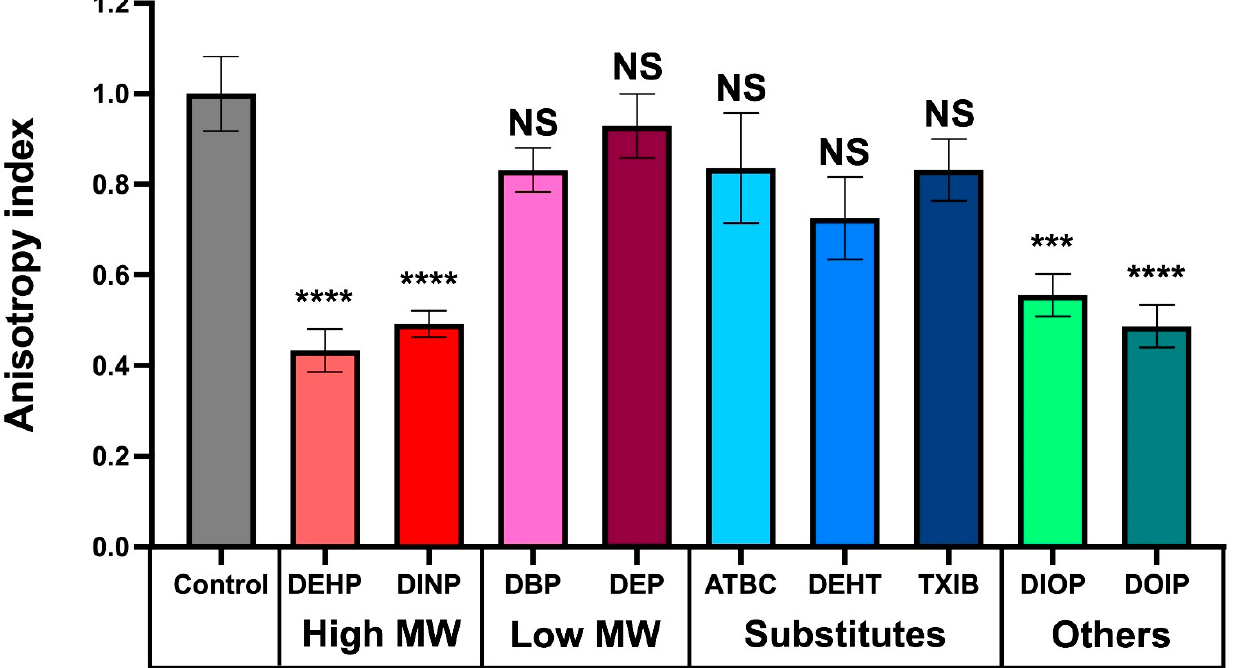
Figure 6. Effect of phthalates and substitutes on membrane fluidity. Anisotropy index variations were observed upon addition of phthalates or substitutes at 10 − 3 M to P. aeruginosa . Graphs represent means ± SEM. NS = p > 0.05; *** = p < 0.001, **** = p < 0.0001.